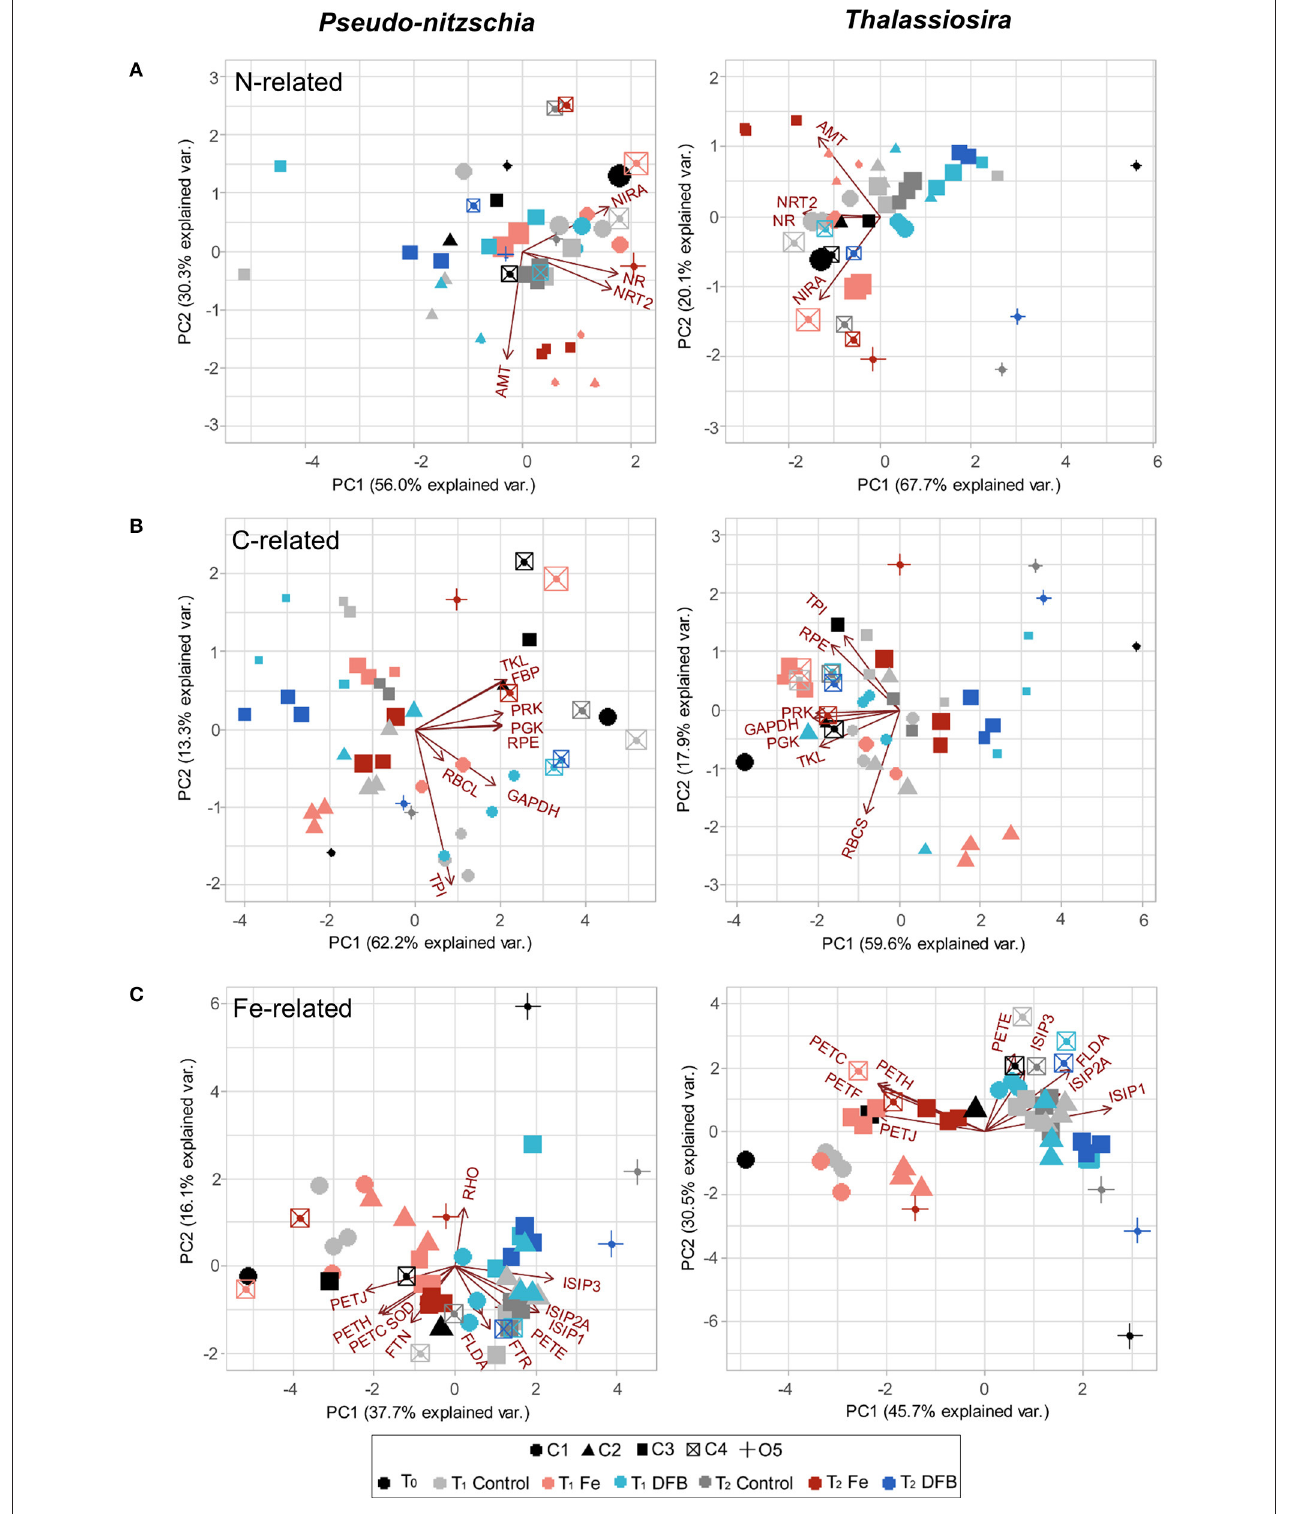
FIGURE 6 | PCA bi-plots depicting the relationship between treatment (color), site (shape), and biomass-normalized N and C rates for transcript abundances of genes involved in N, C, and Fe-related processes in Pseudo-nitzschia (left) and Thalassiosira (right). Size of points scales with increasing PN-specific V NO 3 (day − 1 ) from 0.04 to 1.63 day − 1 (A) , and with increasing PC-specific V DIC (day − 1 ) from 0.01 to 1.50 day − 1 (B). For the Fe-related genes transcript abundance PCA bi-plot, sizes remain constant across samples (C) . See Figure 5 for the list of gene abbreviations.